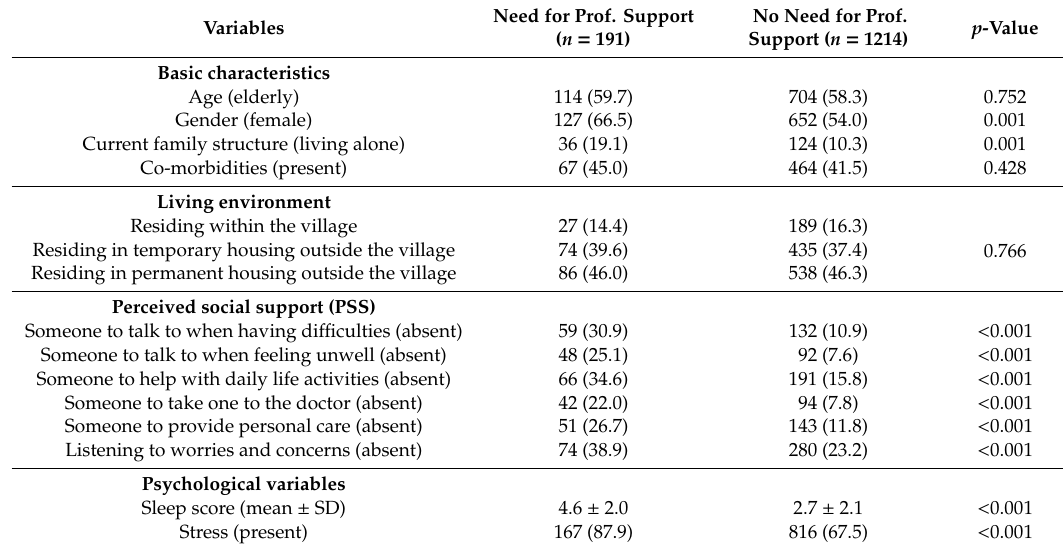
Table 1. Relationships among need for professional support and study variables.